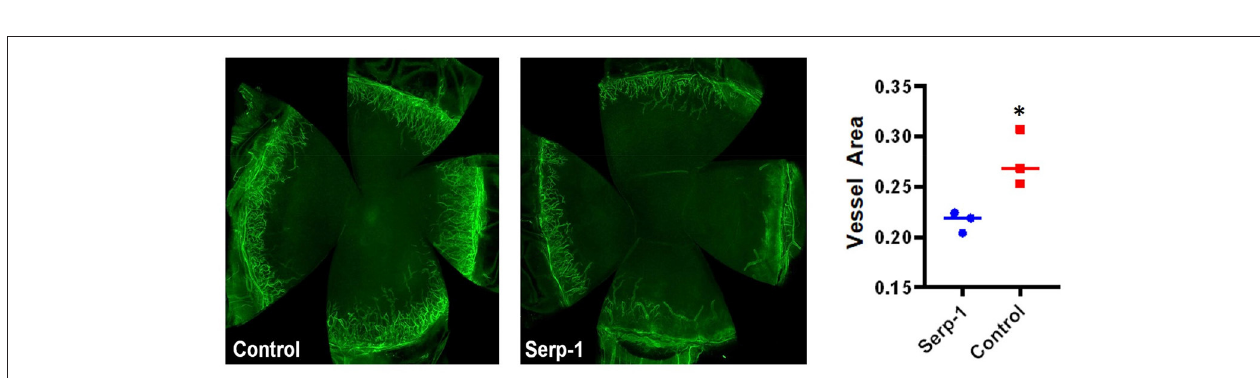
FIGURE 2 | Immunostaining with flat-mounted corneas shows reduced inflammation in Serp-1 treated mice. Anti-CD31 antibody was applied and samples were mounted in buffer containing 4 ′ ,6 ′ -diamidino-2-phenylindole (DAPI). Total vessel area was quantified by dividing the CD31 positive areas by the total cornea area using FijiWin’s ImageJ software, with a significant difference reported between the two treatment groups ( n = 3/group; * p <